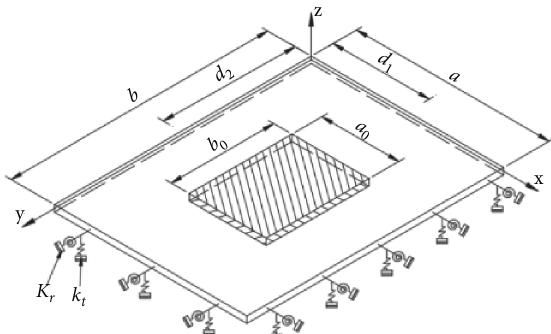
Figure 2: Locally heated laminated plate with elastic boundary subjected to local thermal